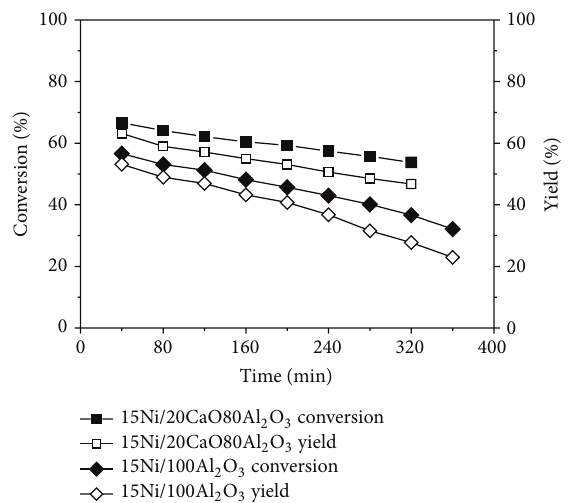
Figure 9: CO 2 conversion and CH 4 yield versus reaction time at 450 ∘